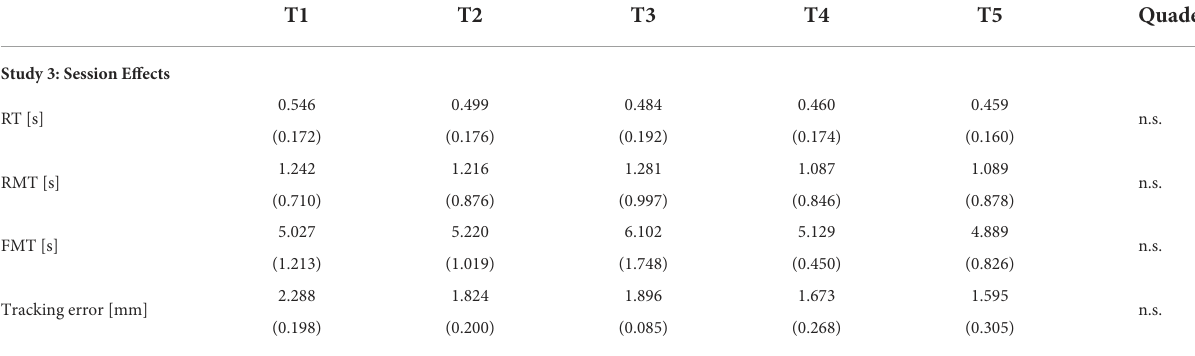
TABLE 6 Session effects on performance measures: Means, SD (in parentheses), and Quade main effects. T1